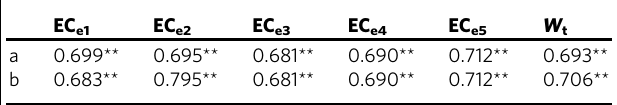
Table 3 Values and levels of global and